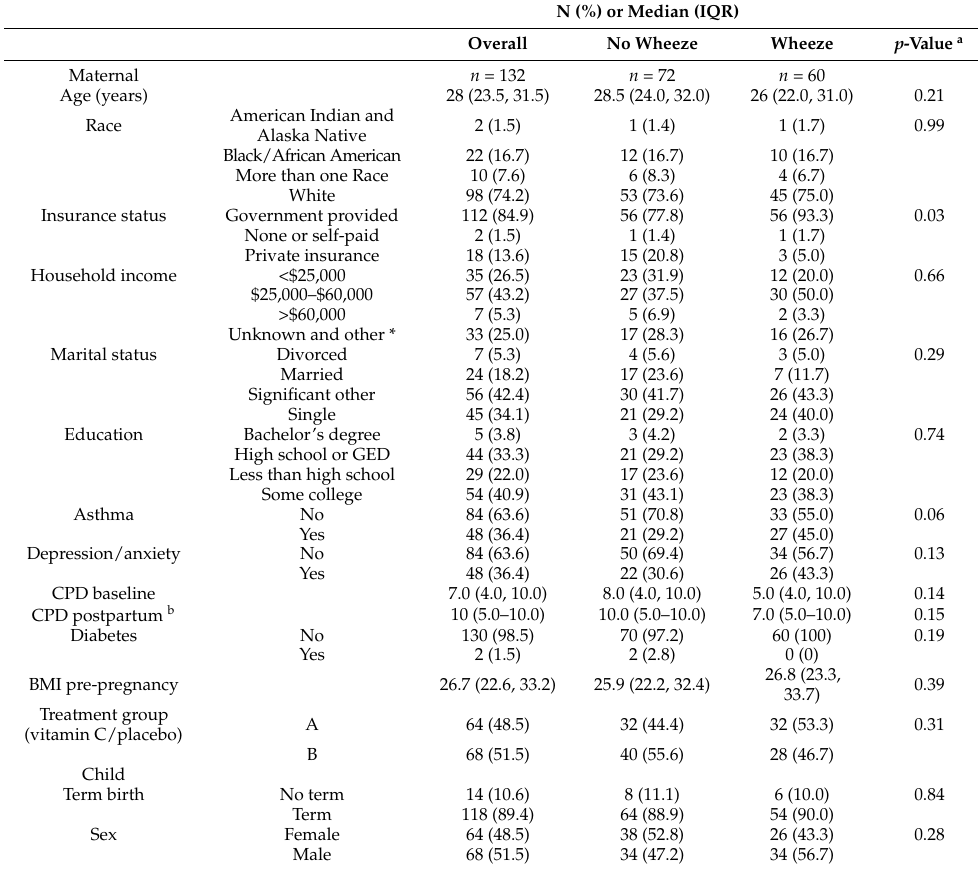
Table 1. Maternal and infant characteristics and wheeze.